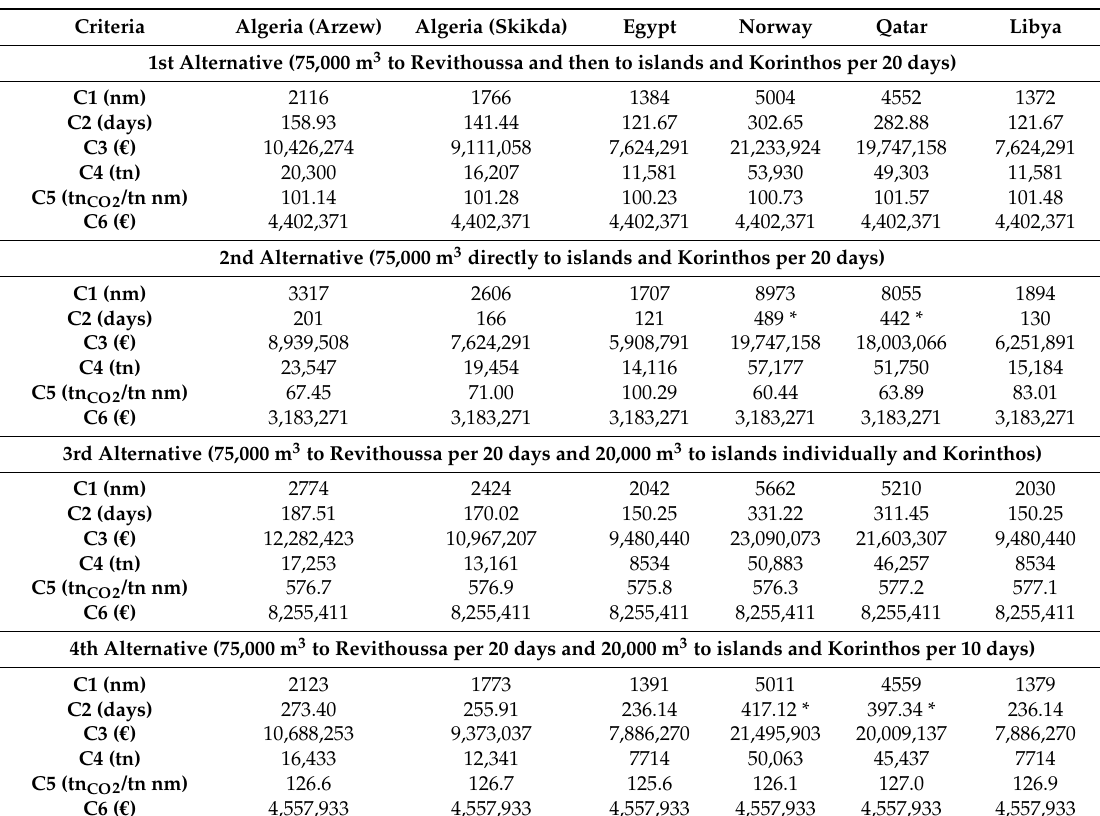
Table 11. The evaluation matrix.